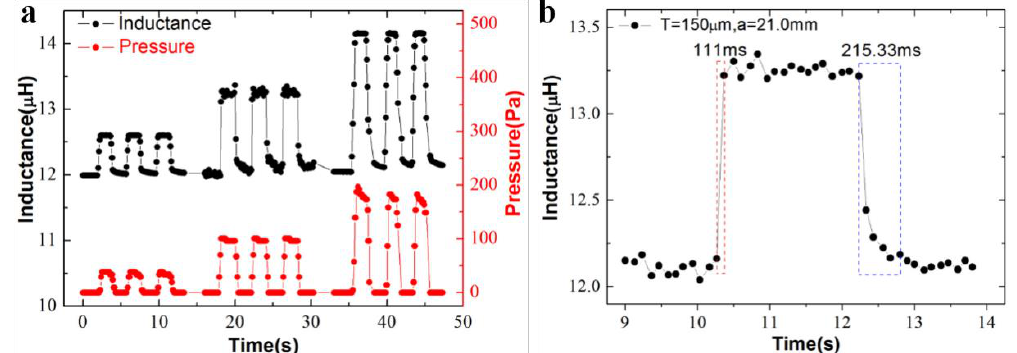
Figure 4. Characterization of the repeatability on the device with 150 µ m in the thickness of the PET / ferrite film and 21.0 mm in the edge length of the ferrite film. ( a ) Inductive changes as a function of repetitive cycles of external pressures varying from 38.45, 107.00 to 177.82 Pa; ( b ) time-resolved inductive responses to repetitive mechanical loads of 107 Pa, from which the response time (111 ms) and the recovery time (215.33 ms) are evaluated from the rising and falling edges.